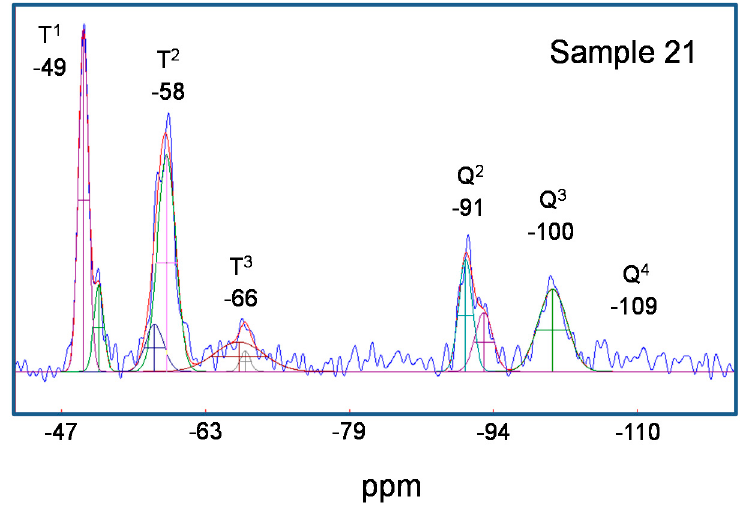
Figure 4 . 29 Si-NMR spectra showing the different T and Q units identified for 21 samples.